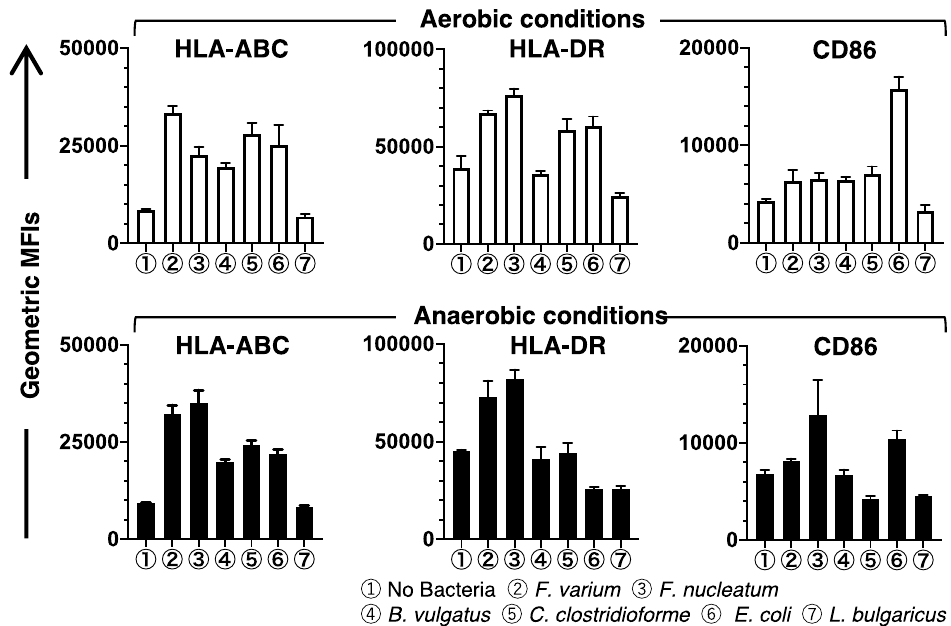
Figure 4. The geometric MFI of the indicated molecules (HLA-ABC, HLA-DR, or CD86) on the surface of the DC line stimulated with live commensal bacteria under aerobic (upper panel) or anaerobic (lower panel) conditions for 4 h followed by an additional 20 h of culture under aerobic conditions (total 24 h). The geometric MFI indicated the expression levels of the indicated molecules on the commensal bacteria-stimulated DC line subtracted from those on the unstimulated DC line incubated without mAbs. The results are presented as the means ± SD from three independent